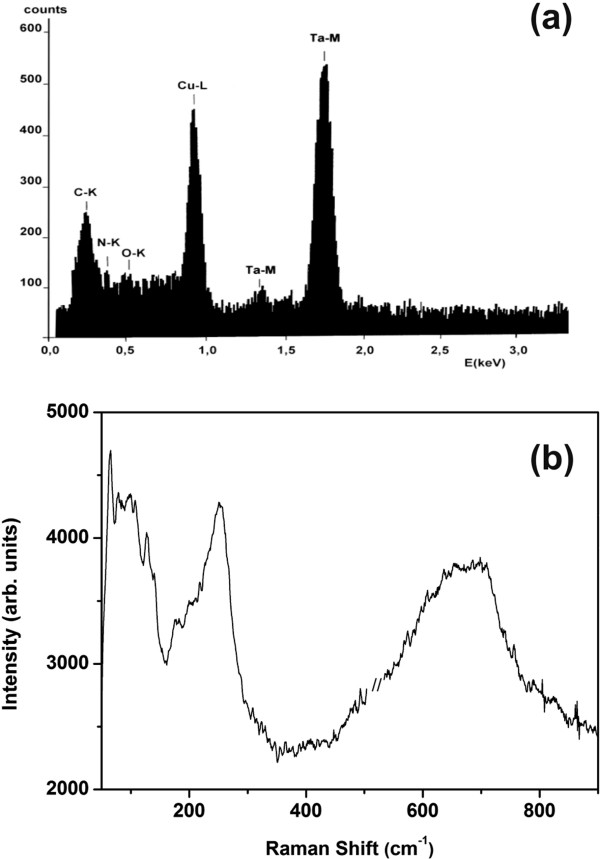
EDXS and micro-Raman spectrum of TaNxdeposited on Si. (a) EDXS spectrum. The presence of nitrogen verifies the formation of a-TaN, and the concentration of oxygen is lower than the detection limit (few wt. %). (b) Raman spectrum of TaNx on Si. The broad peaks indicate the amorphous character of the film.